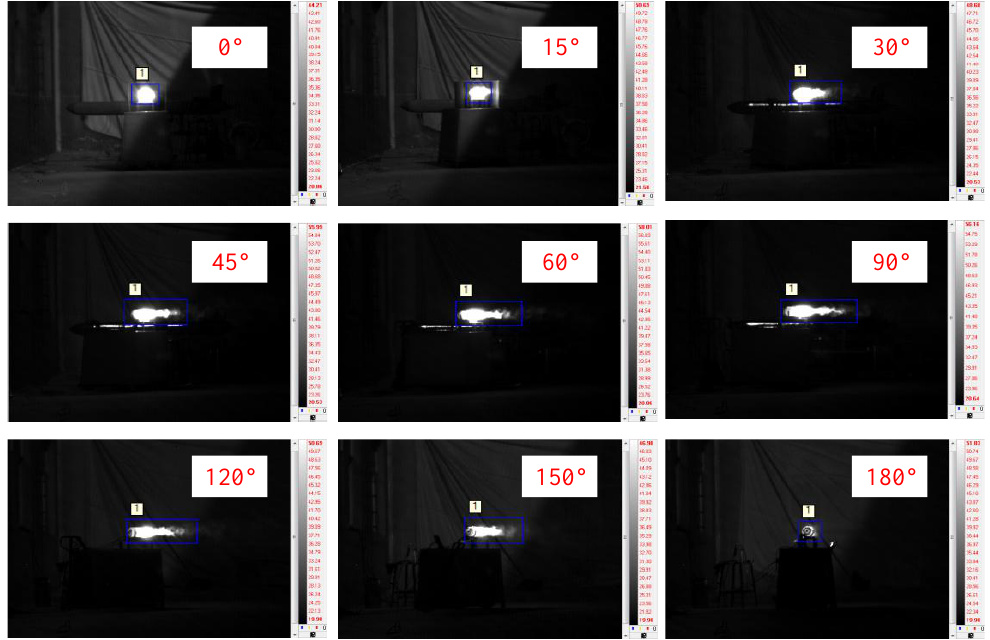
Figure 8. Engine images captured by the mid-wavelength infrared (MWIR) camera at different observation angles.